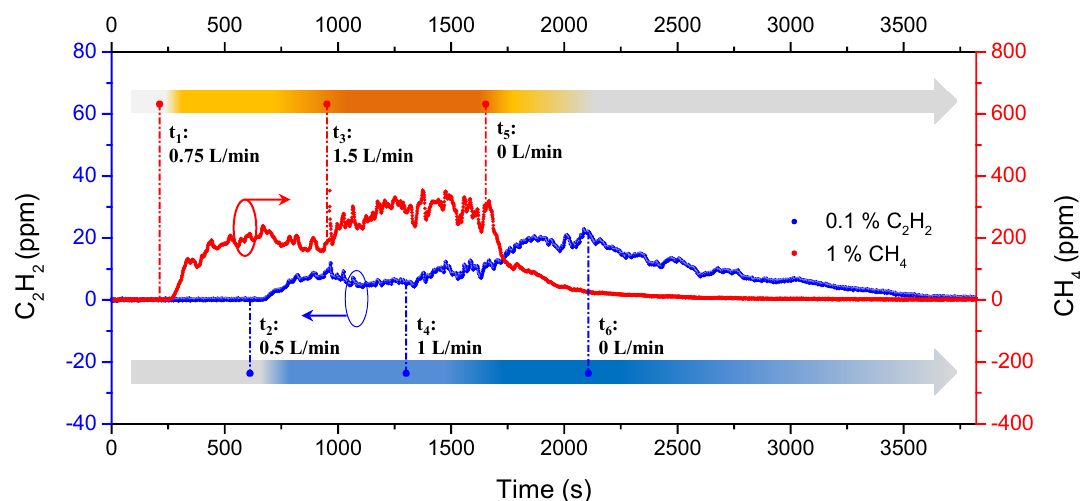
Figure 10. Time history curves of recorded CH 4 and C 2 H 2 concentration at different leakage conditions. t 1 to t 6 represent different leakage rates at different times, and the leakage rate can be controlled by two mass flow meters. The arrows in yellow and blue illustrate the measured relative leakage over time and the dark color means more leakage than light color.